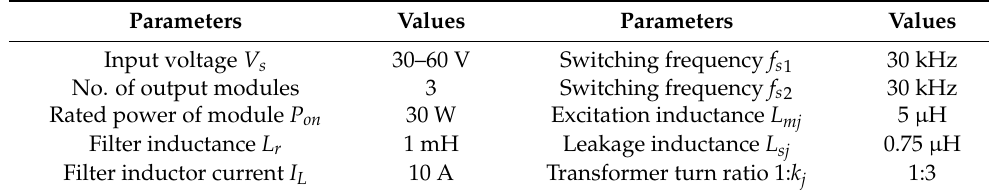
Table 1. The system parameters.